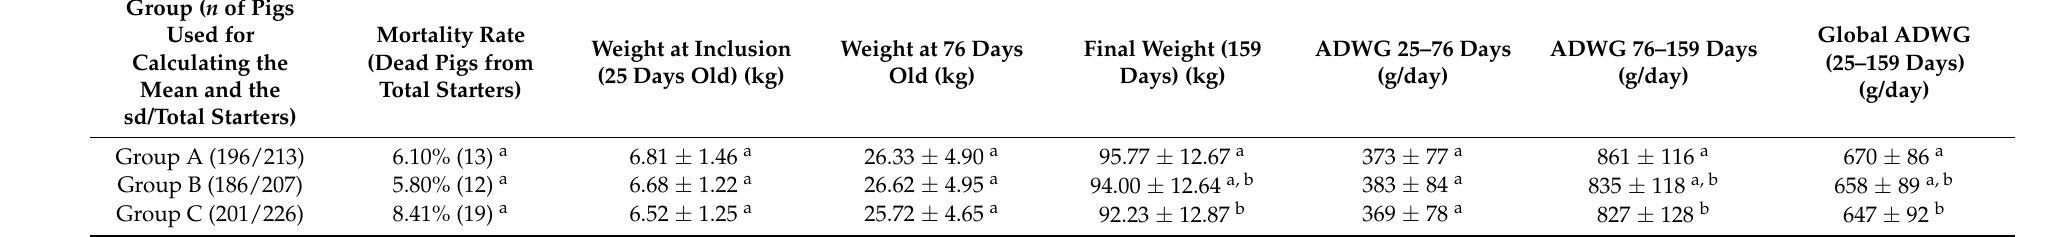
Table 1. Mortality rate and mean ± standard deviation (sd) of the pig weight and average daily weight gain (ADWG) for each group.